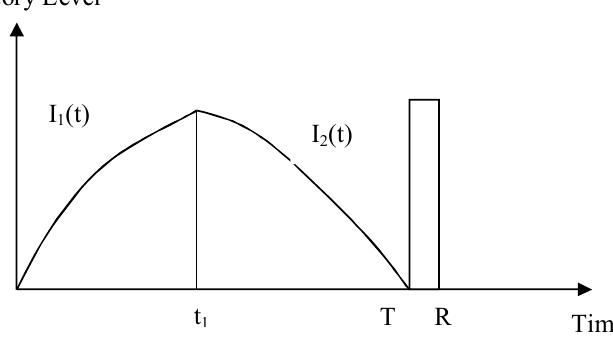
Fig. 1. Inventory versus time (Case-1: T ≤ R )